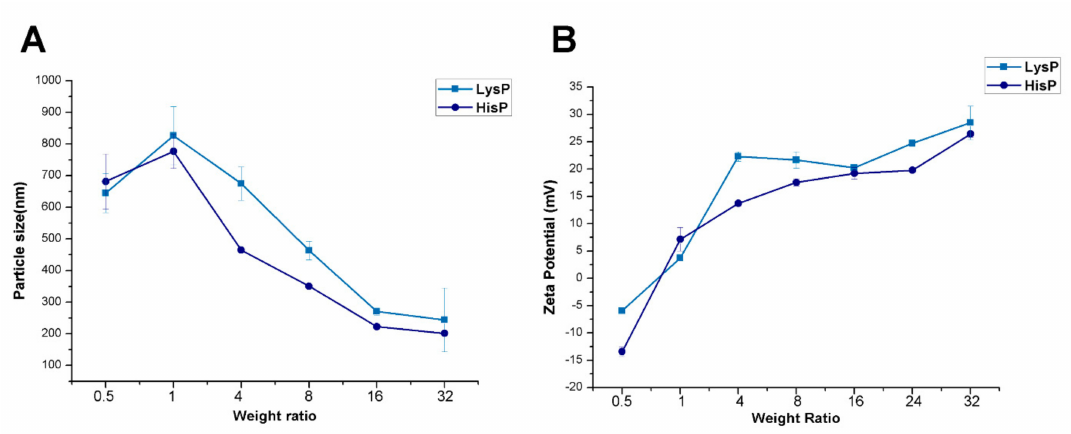
Figure 2. Particle sizes ( A ) and zeta-potentials ( B ) of the polyplexes at various w / w .